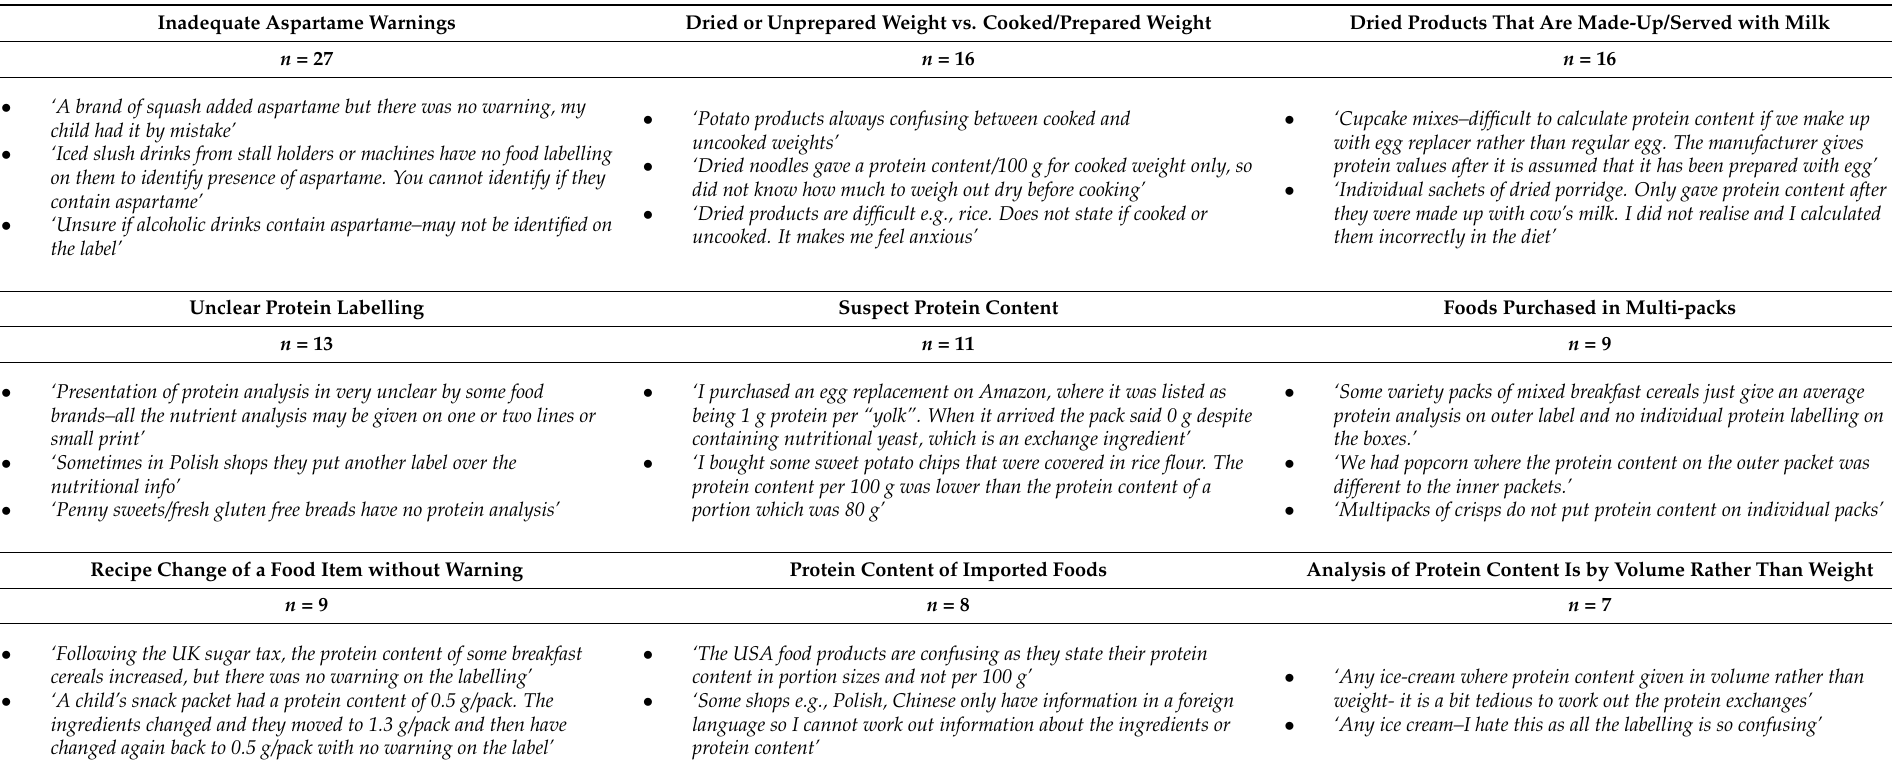
Table 4. Verbatim comments of respondents in 9 thematically analysed categories explaining their practical problems with protein food labelling in the 6 months prior to completion of the